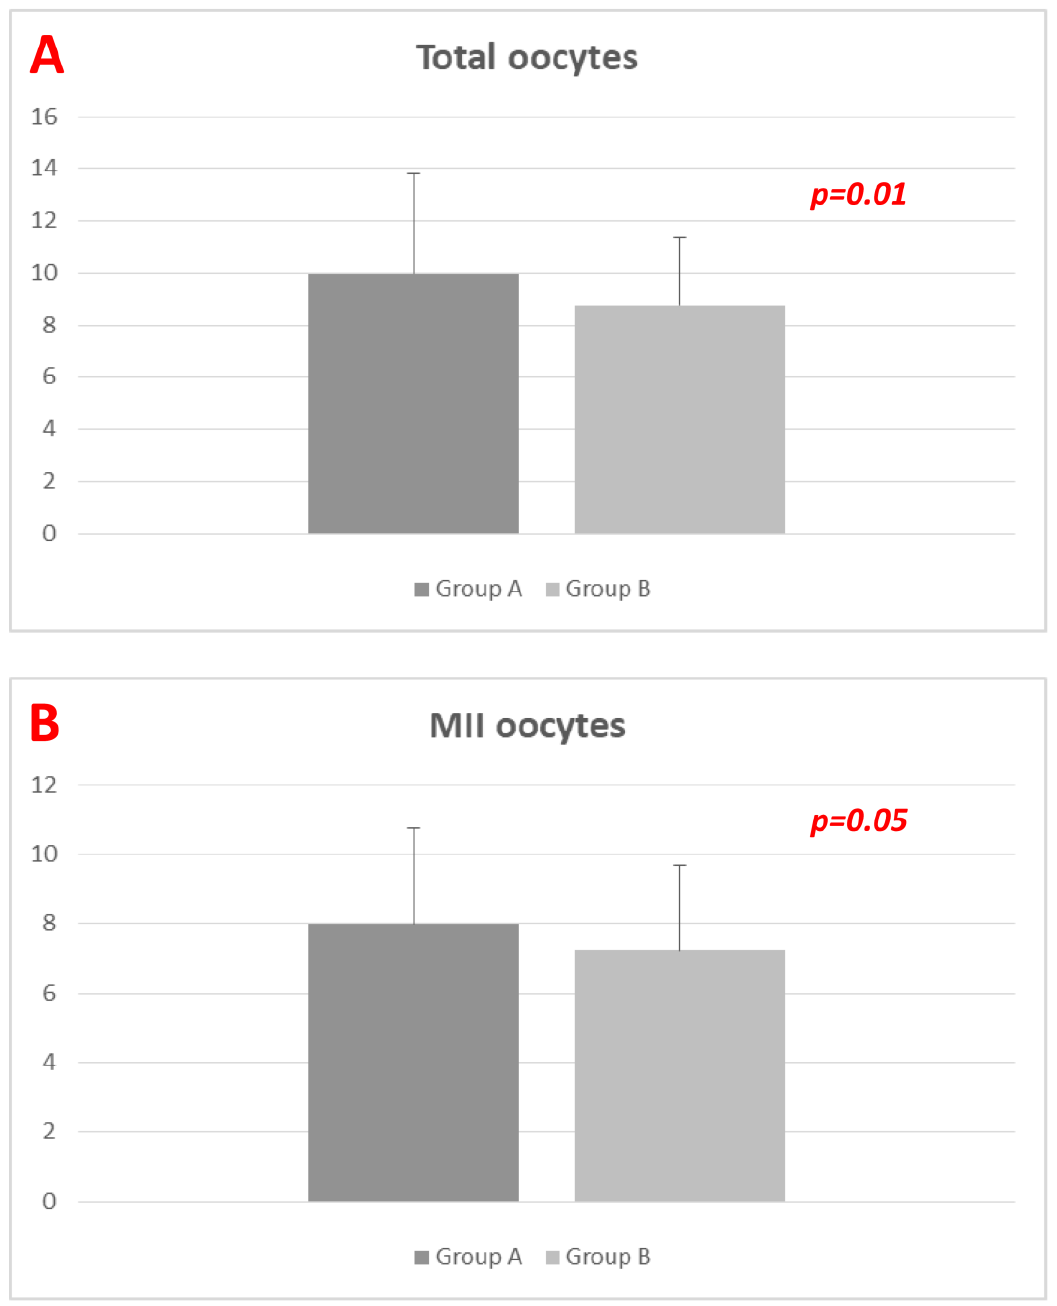
Figure 2. ( A , B ). Number of retrieved total oocytes ( A ) and MII oocytes ( B ) among groups (data expressed as mean ± standard deviation). p -values obtained by using Student’s t -test.